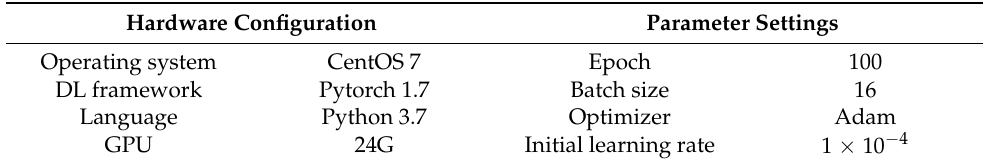
Figure 7. Examples of the images and the ground truth of the INRIA aerial image labeling dataset. Table 2. Experimental environment and parameter ( a ) and ( b ) are the original dataset and the preprocessed image examples, respectively.